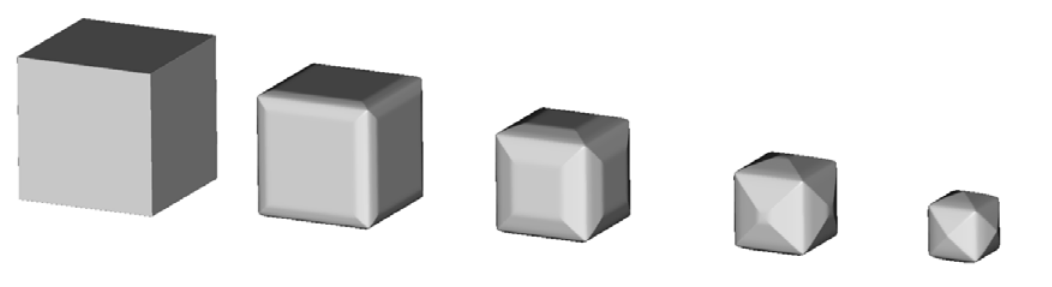
Figure 5. Etching profiles of the silicon cube with initial edge of 30  m after 0 s, 120 s, 240 s, 360 s and 480 s, obtained using the thirteen-parameters interpolation formula for 30% etchant